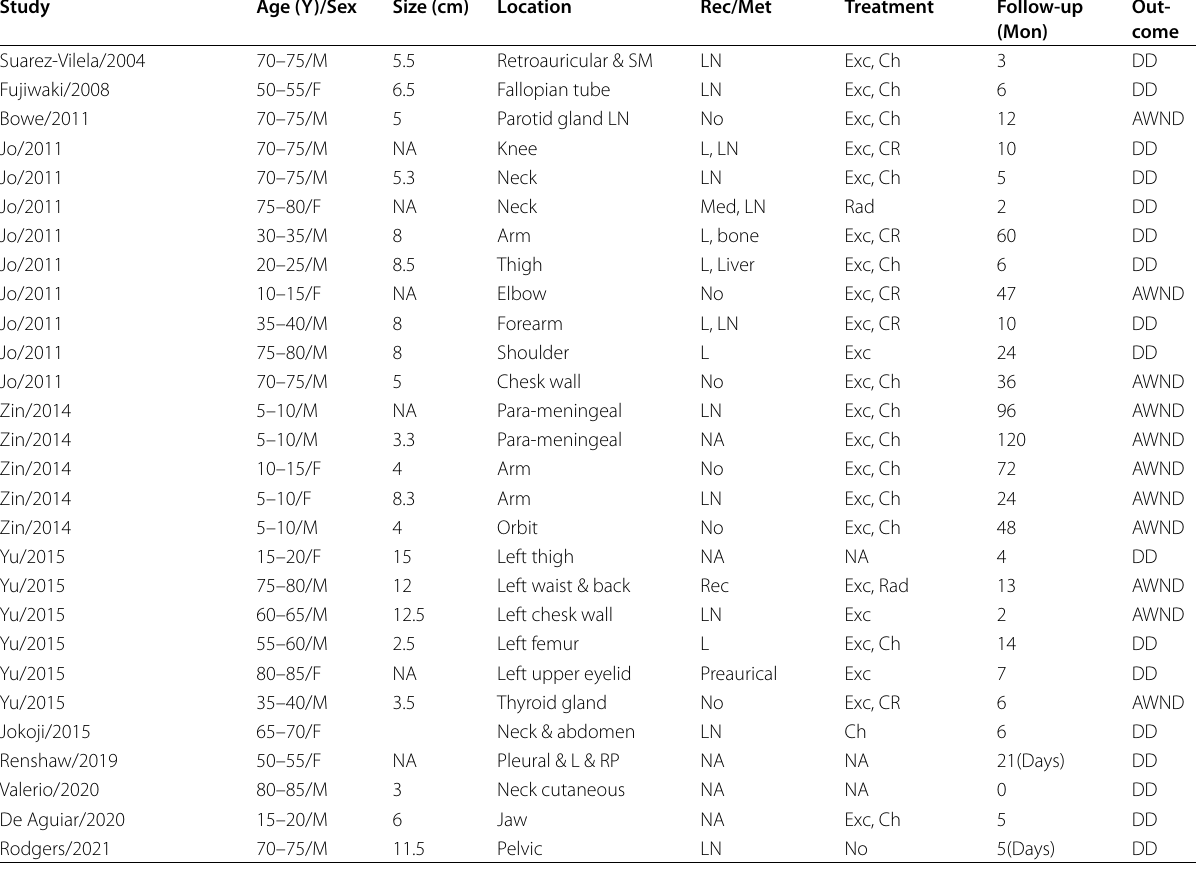
Table 2 Clinicopathological and prognostic characteristics of epithelioid rhabdomyosarcoma